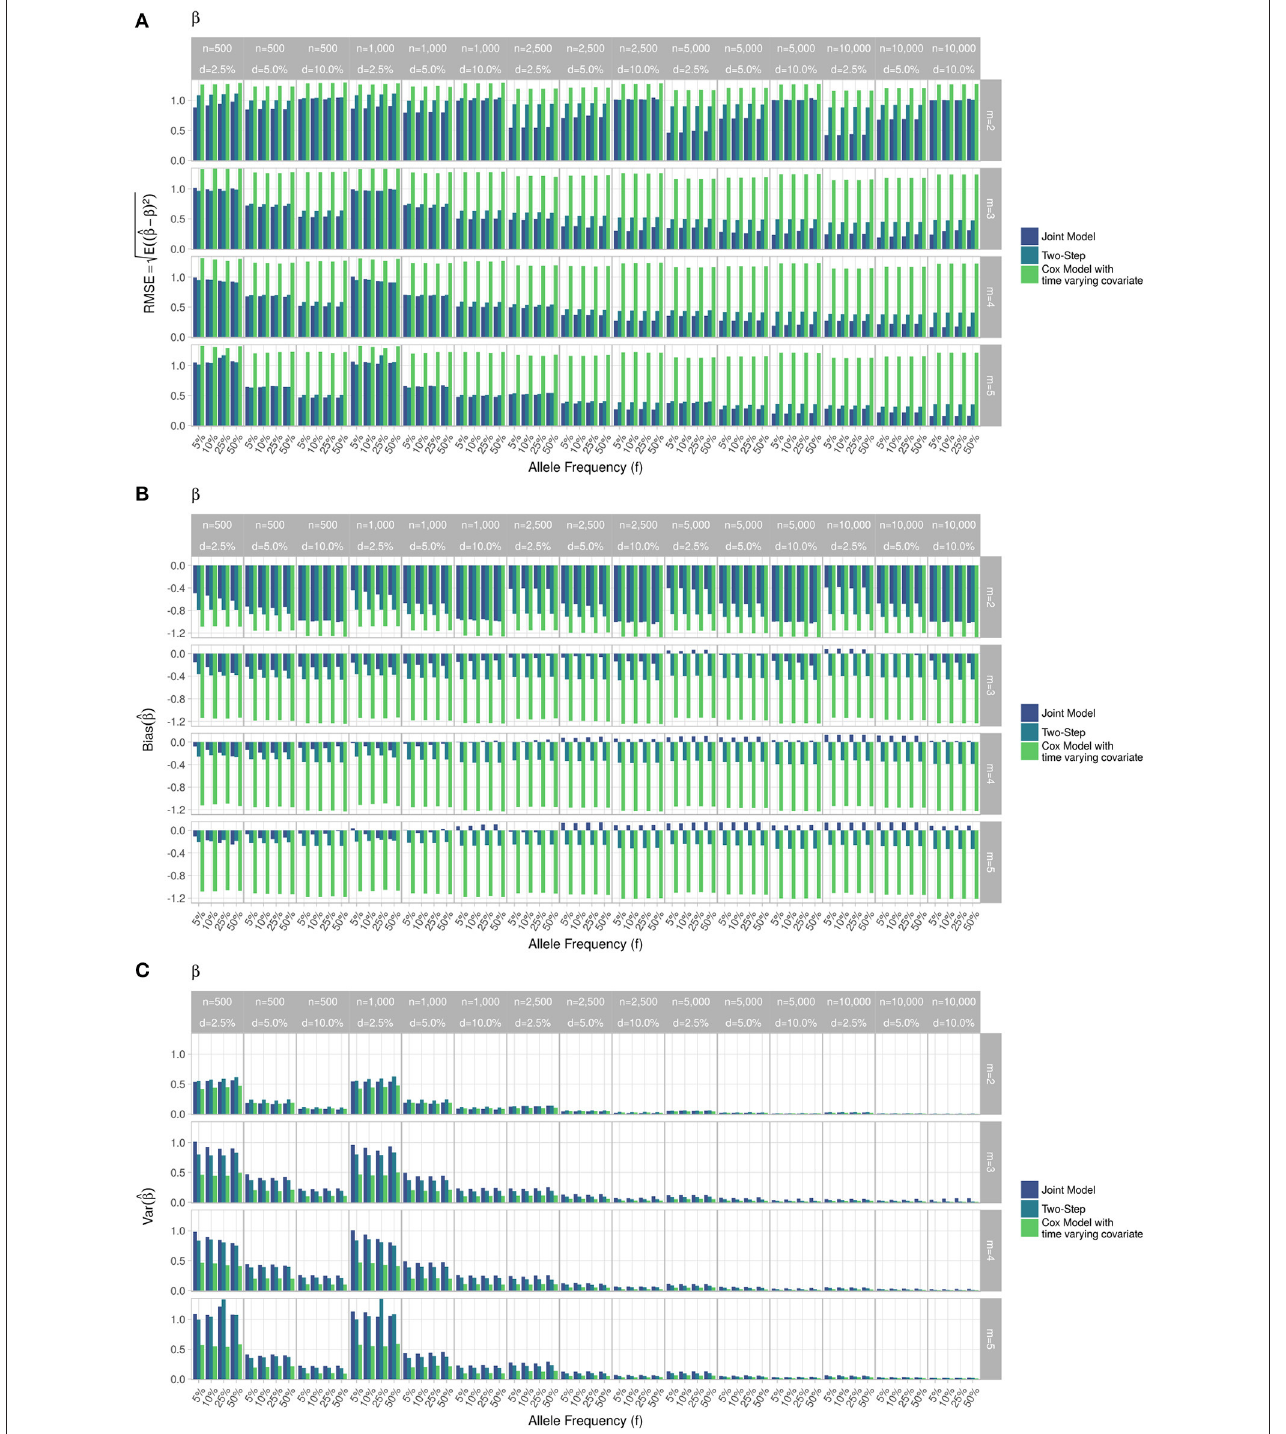
FIGURE 4 | Simulation study for accuracy of estimator ˆ β provided by the joint model (“JM” package), by the two-step linear mixed effect model (“nlme” package) and by the Cox model with time-varying covariate. (A) Displays RMSE, (B) Displays bias and (C) Displays variance. m , number of measures; n , number of individuals; d , diabetes incidence